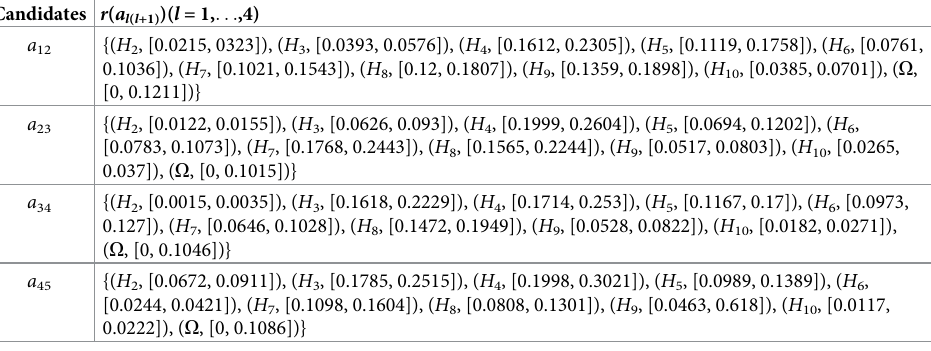
relevant results are shown in Table 3. Table 2. Aggregated IDPRs between neighboring candidates in the manager selection